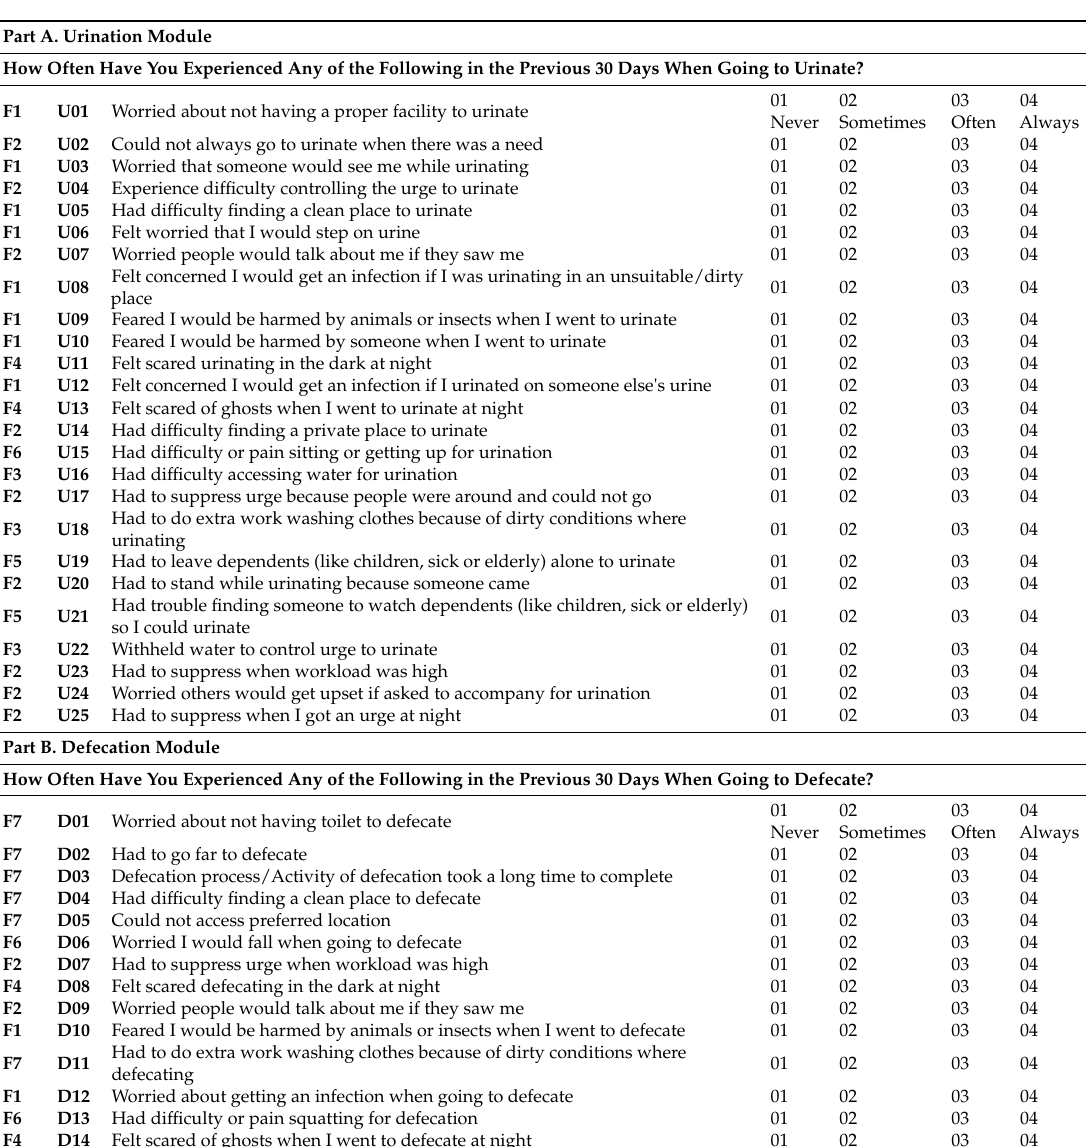
Table A1. Sanitation Insecurity tool, presented with urination and defecation items grouped to facilitate